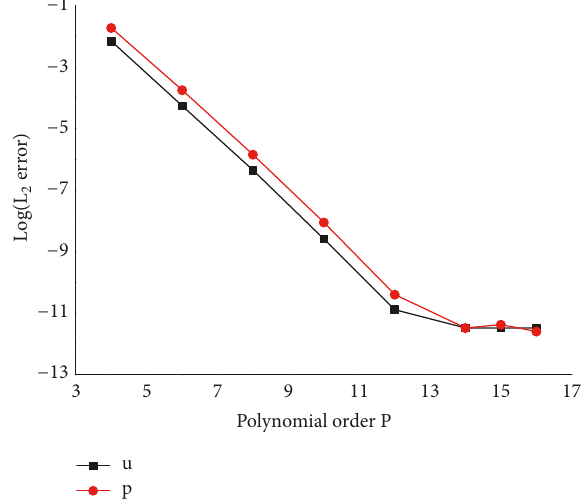
Figure 5: 𝐿 2 norm error convergence curves of pressure and 𝑢 velocity for different polynomial order at Re =